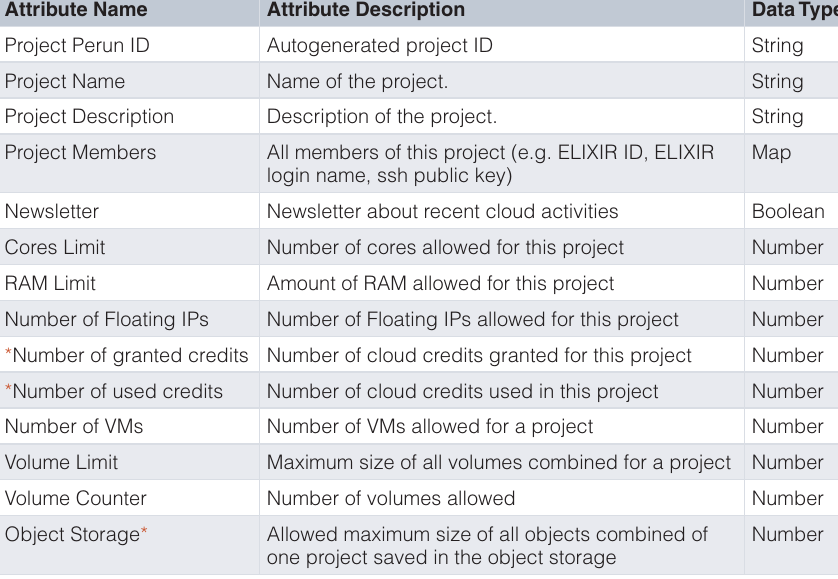
Table 2. An incomplete list of attributes provided by Perun. Attributes marked with (*) are not yet used by the portal or the